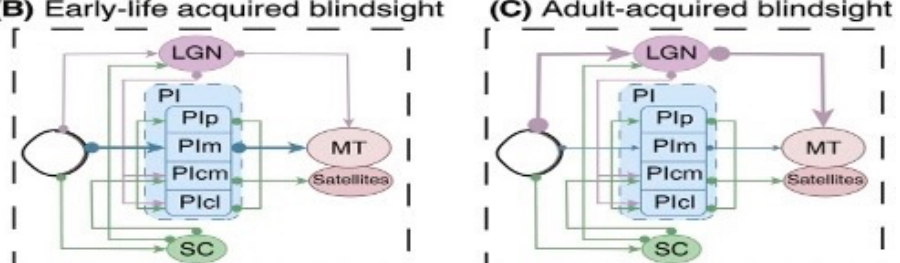
Figure 5. Subcortical pathways capable of facilitating blindsight. ( A ) Medial view demonstrating retinal extrastriatal region feedforward pathways in the posterior parietal cortex. Opaque pathways designate V1 injury neuronal degeneration. ( B , C ) Hypothesized subcortical pathways enabling blindsight after damage in V1 in the child’s ( B ) and in the adult brain ( C ). The strength of the projection is represented by line thickness. (Abbreviations: Amg, Amygdala; LGN, lateral geniculate nucleus; MT, middle temporal area; PI, inferior pulvinar; PIcl, caudolateral division of inferior pulvinar; PIcm, centromedial division of inferior pulvinar; PIm, medial division of inferior pulvinar; PIp, posterior division of inferior pulvinar; PPC, posterior parietal cortex; Pul, pulvinar; SC, superior colliculus) (from Fox at al., [149] with permission).